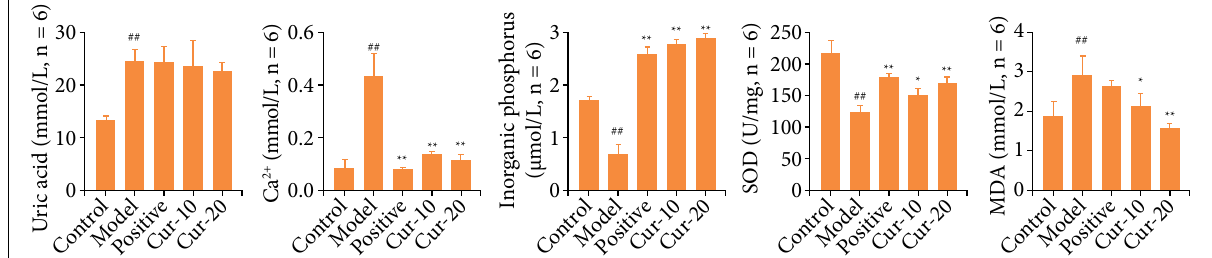
Figure 4 – Kidney tissue biochemical test results. Changes of UA, Ca 2+ , IP, SOD and MDA in kidney tissue (n = 6). The normality test was performed using Shapiro–Wilk, differences between two groups were measured by Student’s t-test. * P < 0.05, ** P < 0.01 means comparison with model group, # P < 0.05, ## P < 0.01 means comparison with the control group.